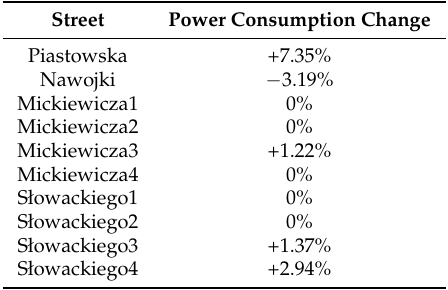
Table 4. Energy consumption change after redesigning to 2014